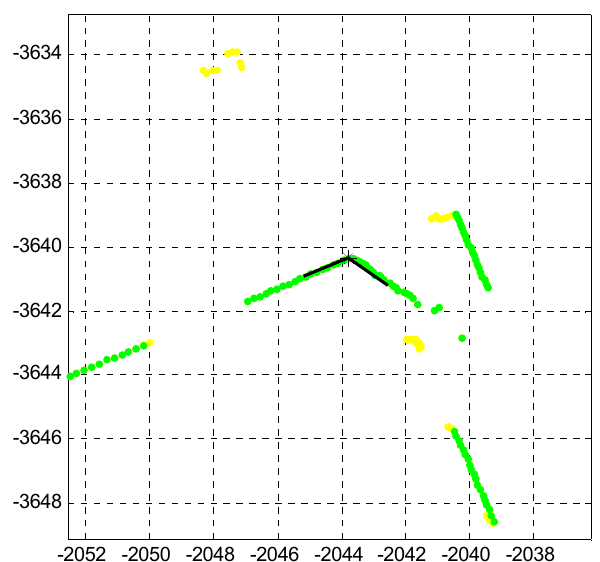
Figure 7. Extracted corner candidate (black star and lines).